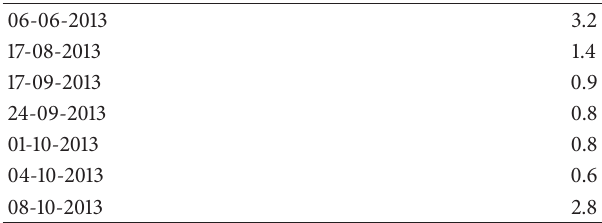
Table 1: Lymphocyte counts before, during, and after Fingolimod